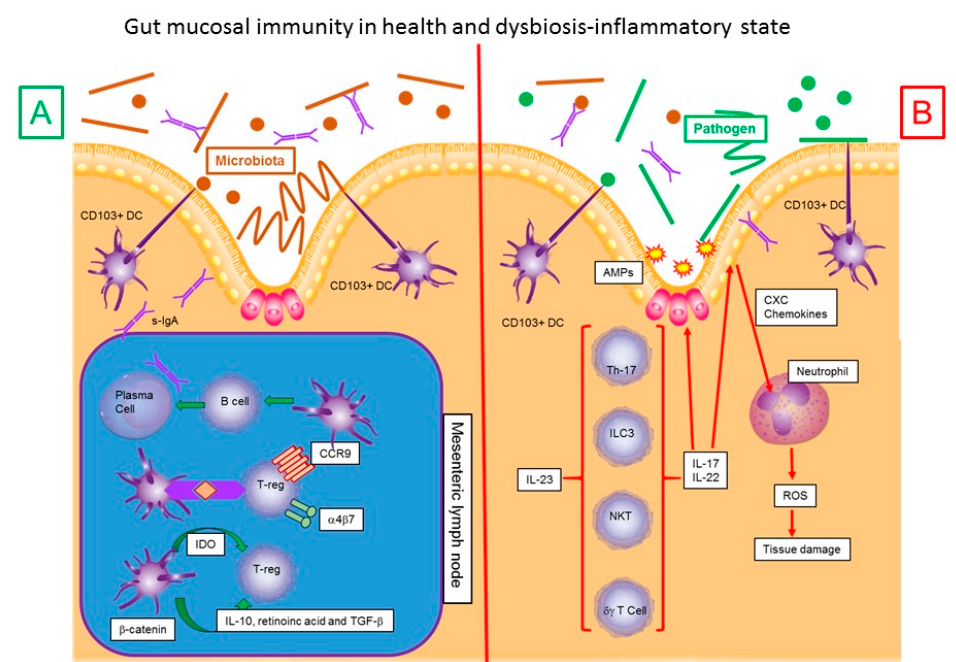
Figure 1. Gut mucosal immunity in health and dysbiosis-inflammatory state schematic representation of the interaction between gut microbiota, dendritic cells and inflammatory response in Gut mucosa in a healthy state ( A ) and gut mucosa in dysbiotic – inflammatory state ( B ). Taken from [11]. α 4 β 7: α 4 β 7 Integrin, AMPs: antimicrobial peptides, CCR9: C-C chemokine receptor type 9, CXC: CXC Chemokines family, DC: Dendritic Cell, IDO: Indoleamine-pyrrole 2,3-dioxygenase, IL-10: Interleukin 10, IL-17:Interleukin 17, IL-22: Interleukin 22, IL-23: Interleukin 23, ROS: Reactive oxygen species, s-IgA: Secretory Immunoglobulin A, TGF- β : Transforming growth factor beta, T-reg: Regulatory T cells, Th-17: T-helper cell 17 lineage, NKT: Natural killer T cells.